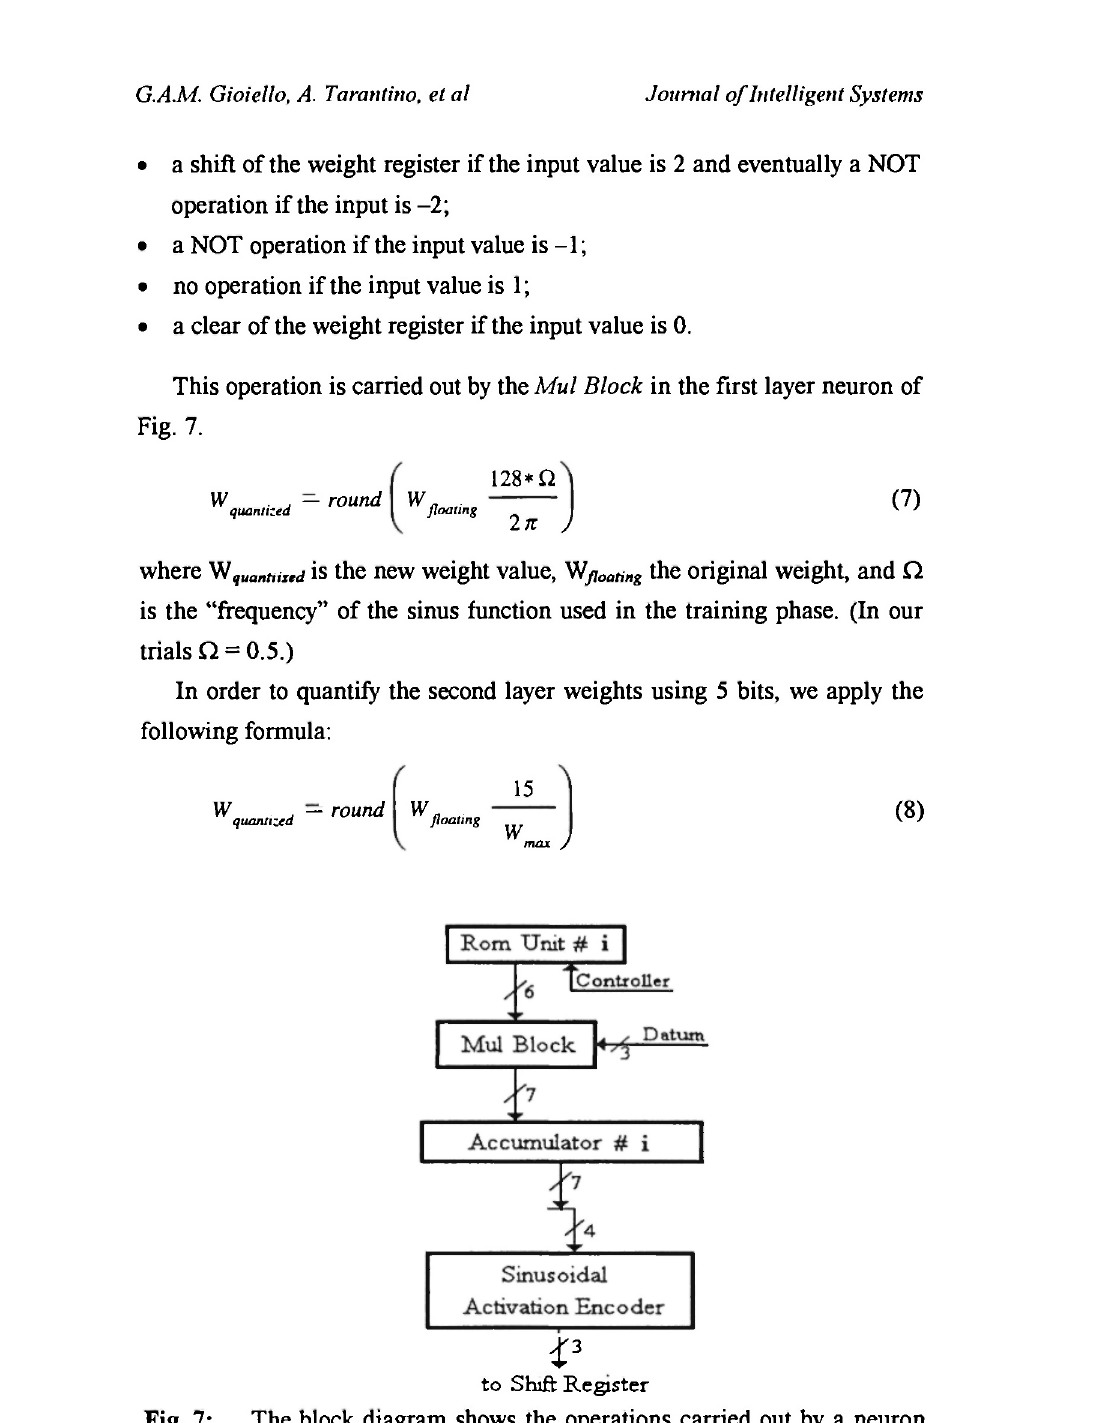
The block diagram shows the operations carried out by a neuron of the first